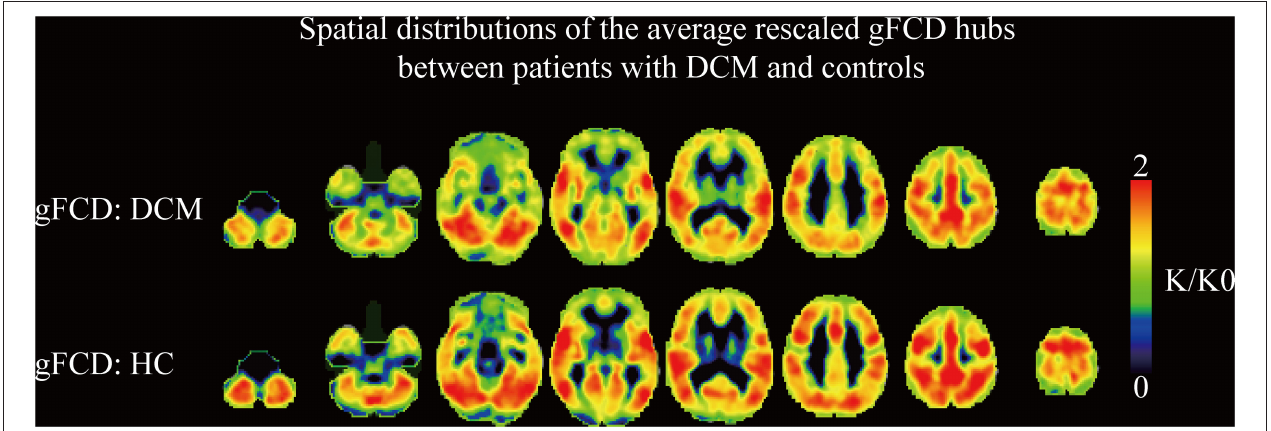
FIGURE 1 | The spatial distributions of the averaged rescaled global functional connectivity density hubs between DCM patients and healthy controls. gFCD, global functional